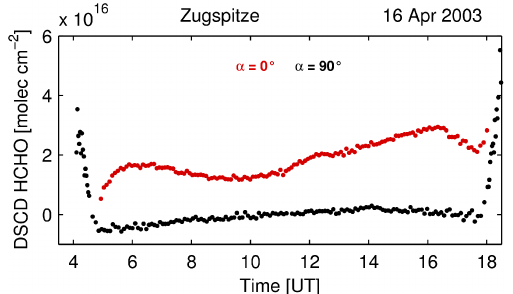
Figure 10. Diurnal evolution of X NO (for SZA<70 ◦ but without 2 Figure 11. Diurnal evolution of HCHO DSCDs for α = 0 ◦ (red) applying the other filter criteria as described in Sect. 6.2) on 16 and α = 90 ◦ (black) on 16 April 2003 at Zugspitze as retrieved from April 2003 at Zugspitze as derived using the 338–357nm (red) and measured spectra using the 338–357nm fitting window. 346–372nm (blue) fitting windows.